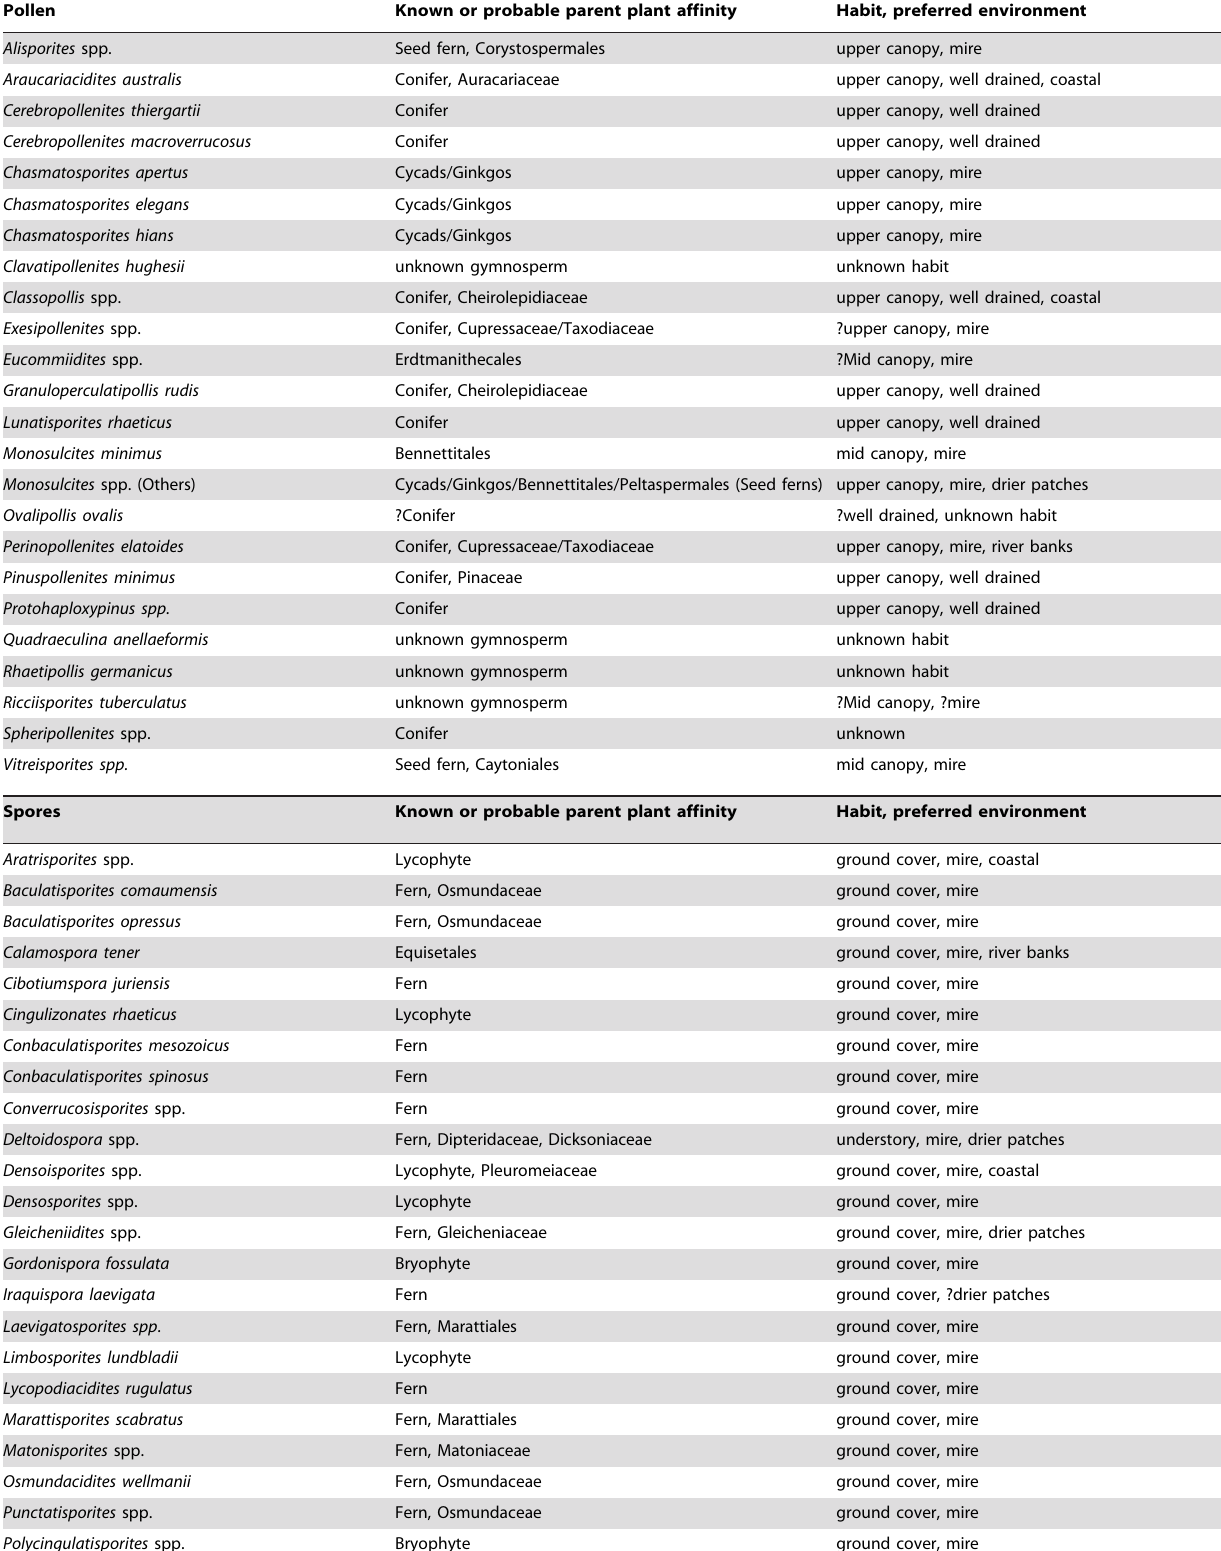
Table 1. List of known or probable parent plant affinity of the identified spores and pollen, and preferred habit and environment.